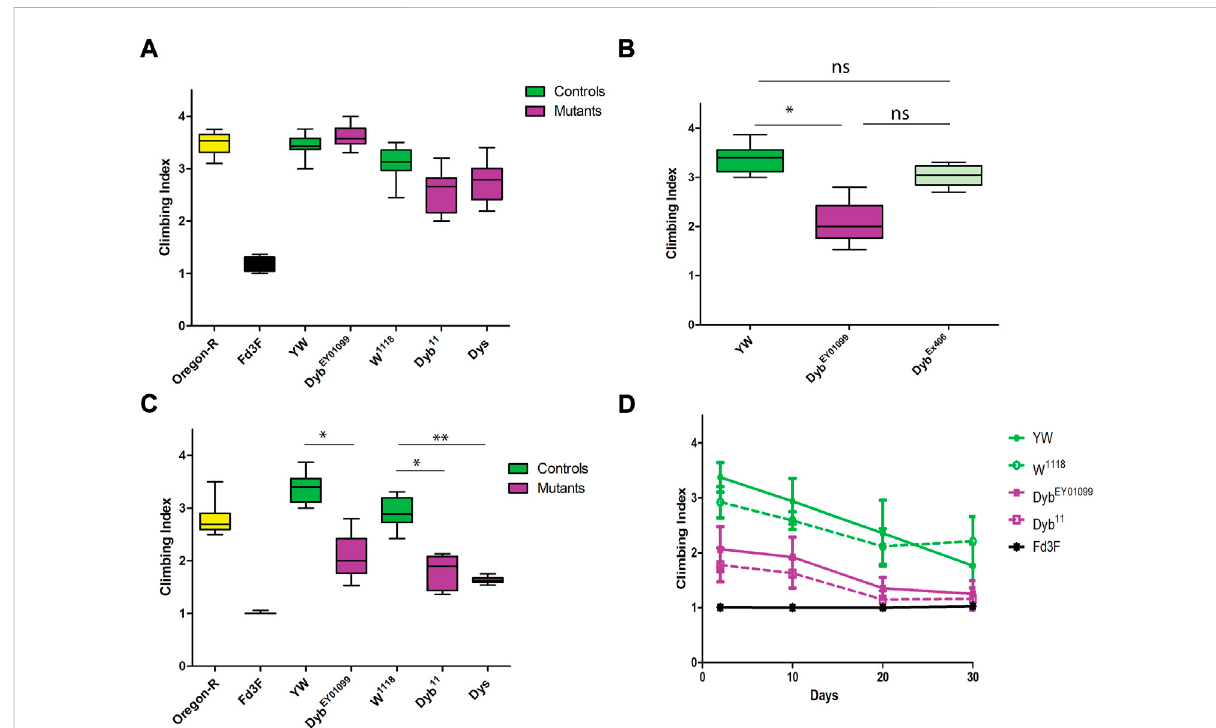
FIGURE 2 ProprioceptionabilityisdefectiveinDGCmutantsandchangesovertime.Performanceofadultfemales(day2aftereclosion)inclimbingassay. The results of N = 10 groups of 15 females are presented as median and interquartile ranges. Flies mutant for Fd3F (Black) have poor climbing ability due to non-functional chordotonal neurons, and Oregon-R (yellow) is a wild-type control. (A) Performance under natural light conditions showed that Dyb EY01099 , Dyb 11 , and Dys (magenta) mutant fl ies exhibit normal climbing behaviour compared to their respective controls (green). (B) Performance under red light conditions showed that Dyb EY01099 and Dyb 11 mutant fl ies have signi fi cantly reduced the climbing ability compared with controls. (C) Under red light, Dyb Ex406 fl ies (a Dyb EY01099 revertant line in which the P element impairing the Dyb gene has been excised) show signi fi cantly improved climbing ability compared with Dyb EY01099 fl ies. In addition, there is no signi fi cant difference between the control yw and Dyb Ex406 . (D) Climbing ability of aging fl ies under red light are presented as mean ± SD. The graph shows the result of Fd3F (Black), Dyb EY01099 (magenta), Dyb 11 (magentaanddashedline),andtherespectivecontrols, yw (green)and w 1118 (greenanddashedline).Underredlight, fl ieswitheither Dyb nullmutation, Dyb EY01099 and Dyb 11 ,showamildproprioceptivede fi citinaclimbingassayrelativetothecontrollinesatallyoungandmiddleages (2 – 20 days after adult eclosion). For climbing assay data, signi fi cance was determined by the Kruskal – Wallis test, with Dunn ’ s test for multiple comparisons.However,onlythesigni fi cantresultsforDGCmutants(magenta)comparedtotheirrespectivecontrols(green)areshown.Signi fi cance on plots is signi fi ed by asterisks: * p ≤ 0.05; ** p ≤ 0.01; *** p ≤